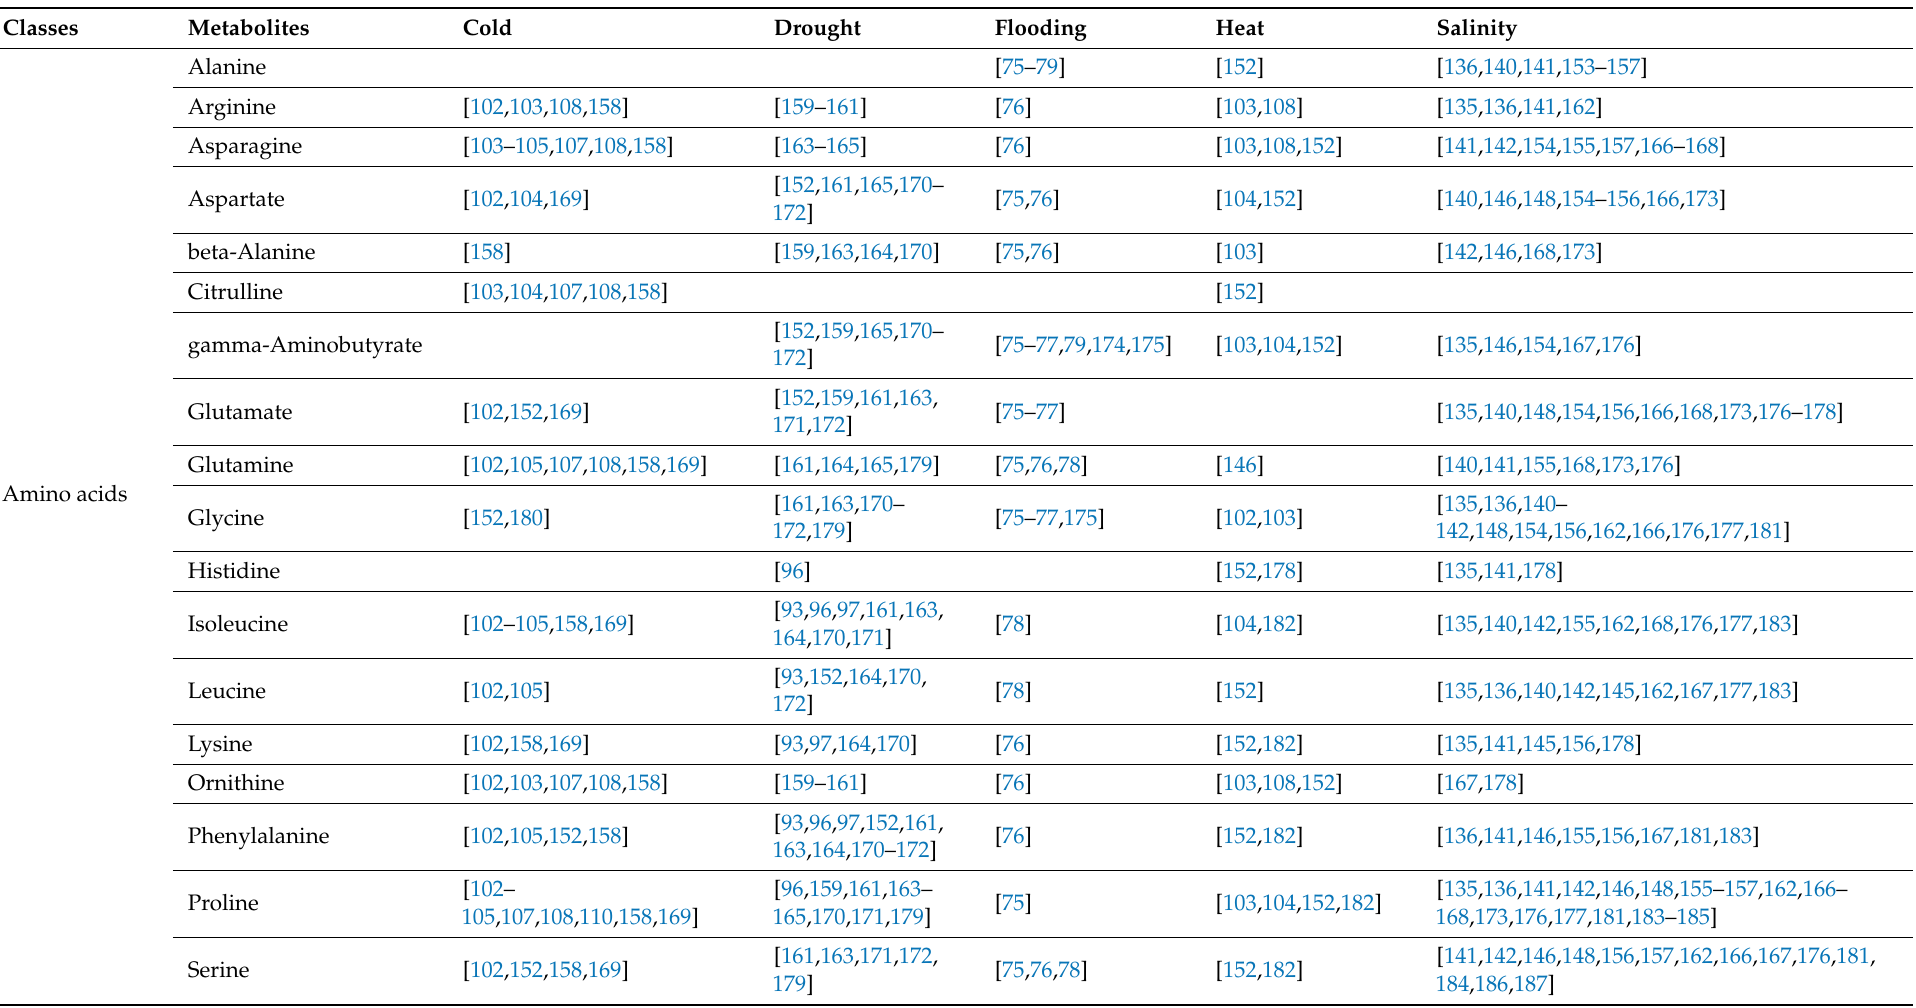
Table 1. List of significantly changed central metabolites under cold, drought, flooding, heat, and salinity stress from published